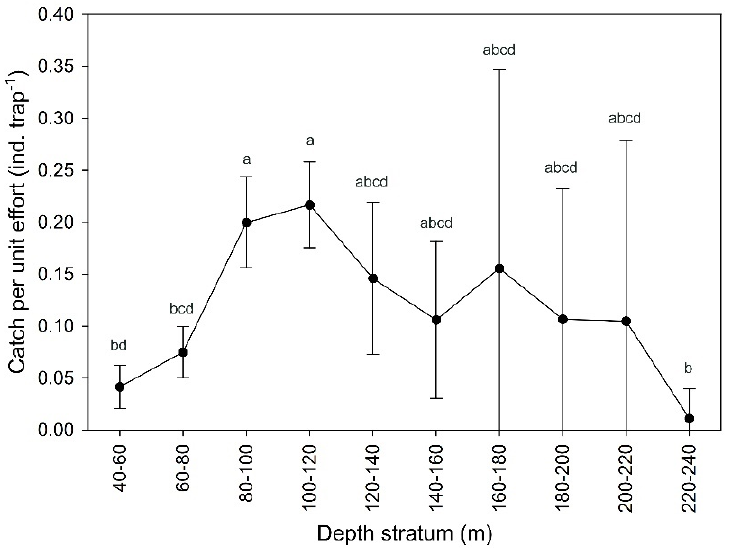
Figure 1. Mean ± 0.95 confidence interval catches per unit effort (CPUE, ind. trap − 1 ) by depth stratum of Palinurus elephas from the Azores for the period 2000–01. Different letters indicate significant differences between groups (Bonferroni post–hoc correction, p -value <